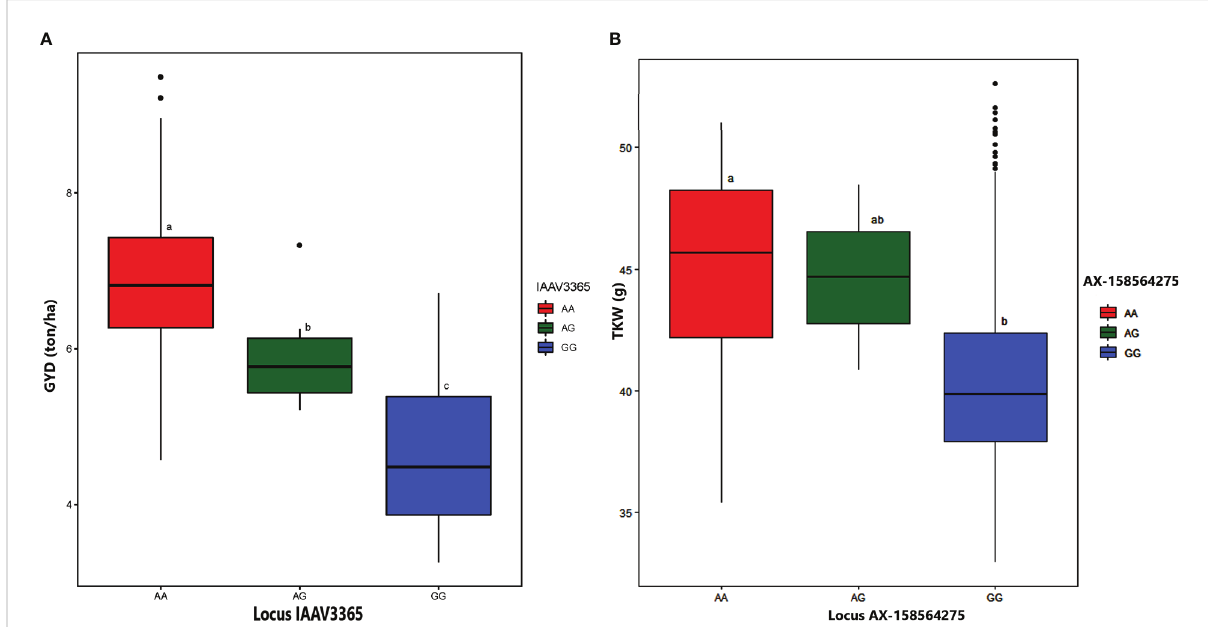
FIGURE 8 Boxplot depicting the effect of alleles located on locus IAAV3365 on grain yield (A) and locus AX-158564275 on thousand kernel weight (B) . The estimated mean BLUEs value was used to generate the boxplot to reveal the effects of respective alleles on grain yield and thousand kernel weight. Tukey´s HSD (Honestly Signi fi cant Difference) test was applied to see the differences of alleles in 420 durum wheat genotypes. The letters above the boxplot indicate the signi fi cant differences among the mean performance of genotypes carrying each allele at a probability level of p< 0.05 .